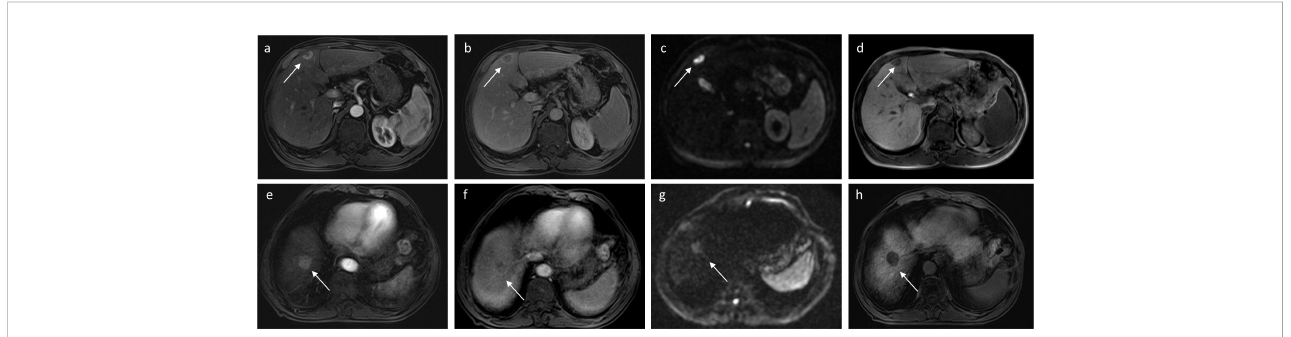
FIGURE 2 A 56-year-old man with sHCC was observed with early IDR after receiving RFA as the fi rst-line therapy. Axial arterial (A) and delayed phases (B) show a well-de fi ned tumor (white arrow) with rim APHE in hepatic segment IV. On the DWI (C) , the tumor exhibits targetoid restriction and the tumors showed targetoid HBP appearance on hepatobiliary phase (D) . Another 76-year-old man with HCC was observed with no recurrence after RFA during 13 months of the follow-up period. Axial arterial (E) and delayed phases (F) show a well-de fi ned tumor (white arrow) with APHE in hepatic segment VIII. On the DWI (G) , the tumor exhibits appeared restriction, and the tumors exhibit completely hypointense on hepatobiliary phase (H)